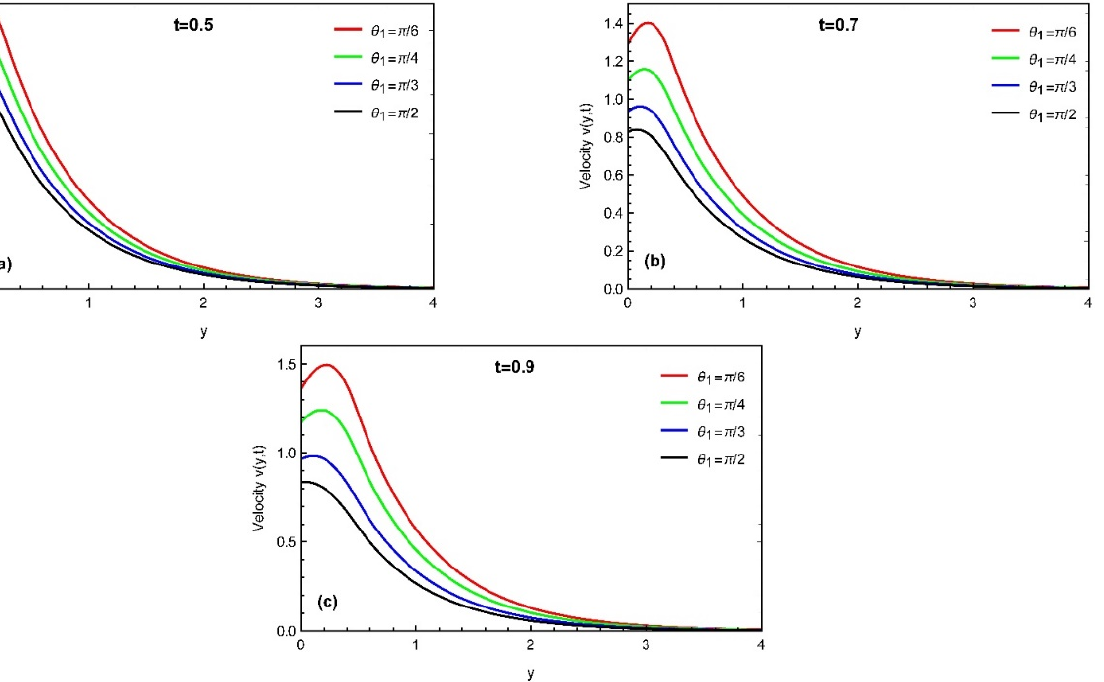
Figure 13. Variation in momentum field due to inclined of the magnetic field with α = β = γ = 0.7, Pr ef f = 1.4, Sc ef f = 1.1, M = 1.75, Gr = 0.75, Gm = 0.5, Re = 1.3, θ 2 = π ( a ) t = 0.5 ( b ) t = 0.7 ( c ) t =